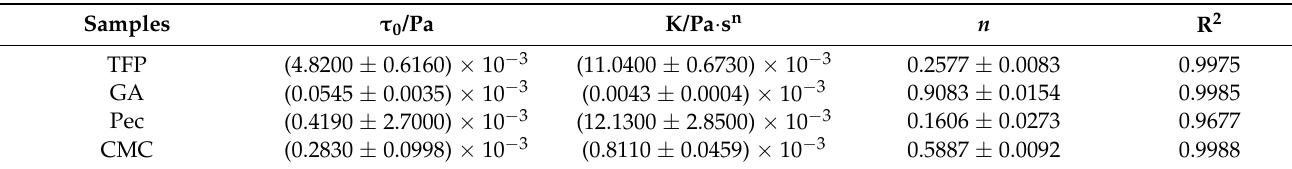
Table 3. Herschel–Bulkley model fitting parameters for rheological curves of different